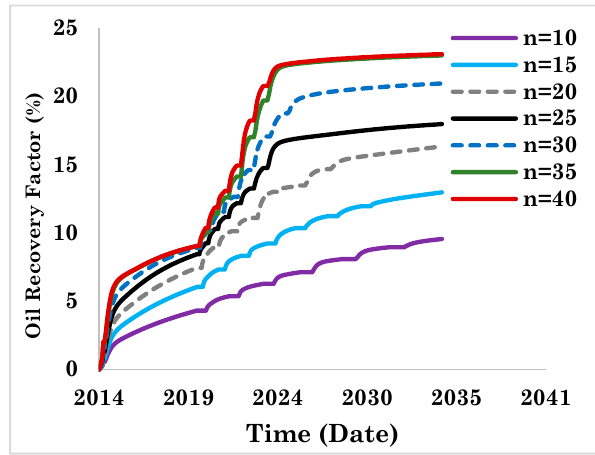
Figure 18. CO 2 Injection (Fixed Cycle Size) 31 API Oil.